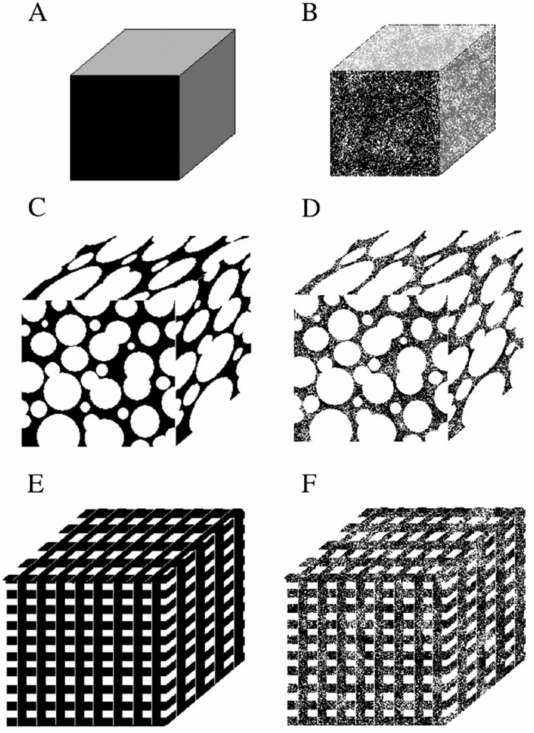
Figure 8. Schematic drawings of various types of the ceramic porosity: ( A )—nonporous, ( B )—microporous, ( C )—macroporous (spherical), ( D )—macroporous (spherical) +